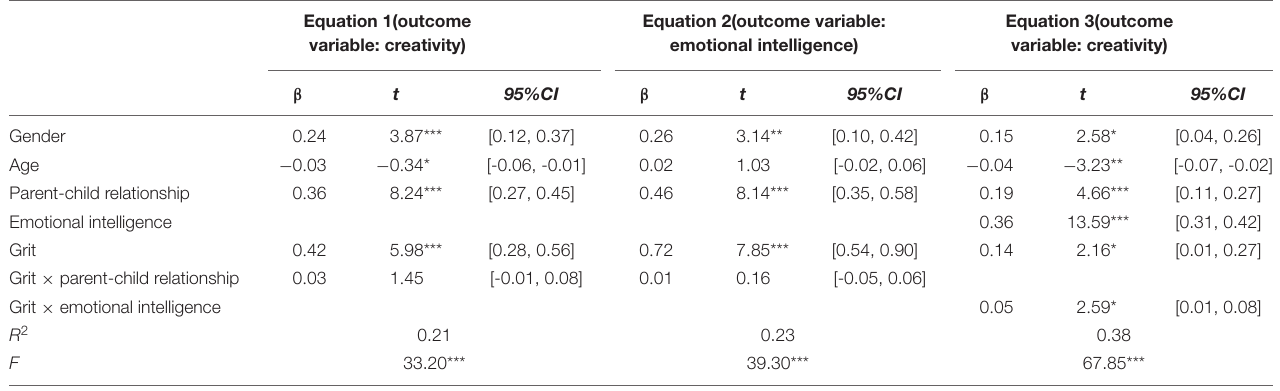
Equation 2(outcome variable: emotional intelligence)